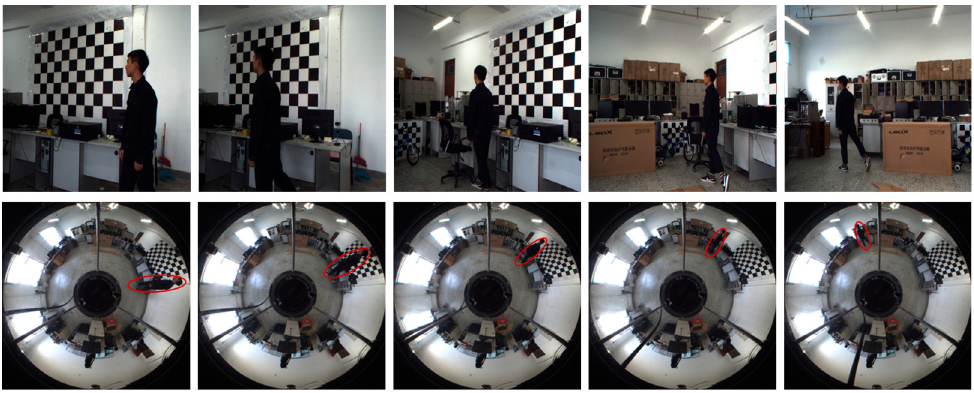
Figure 13. The tracking and cooperation result of the two cameras. From left to right, the 17th, 26th, 35th, 43rd, and 85th frame are shown.